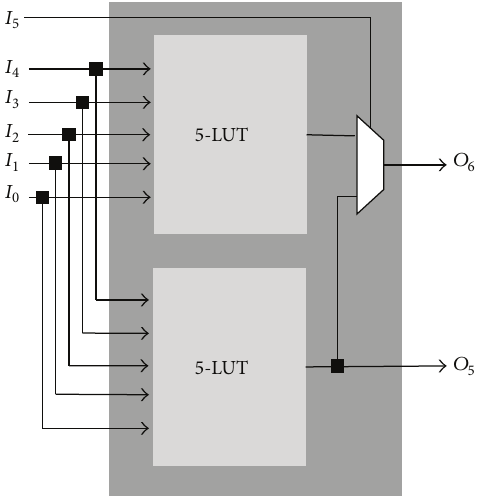
Figure 2: Xilinx 6-input dual LUT for 5th-, 6th-, and 7th-generation